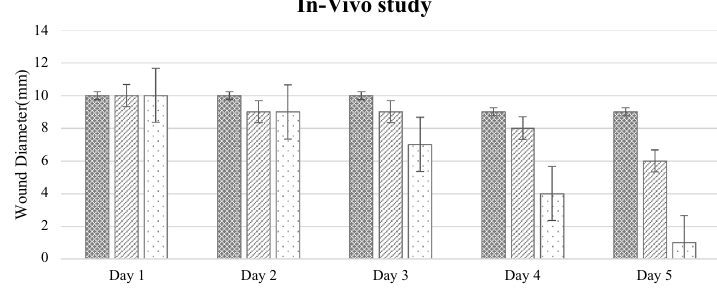
Fig. 21 Wound healing